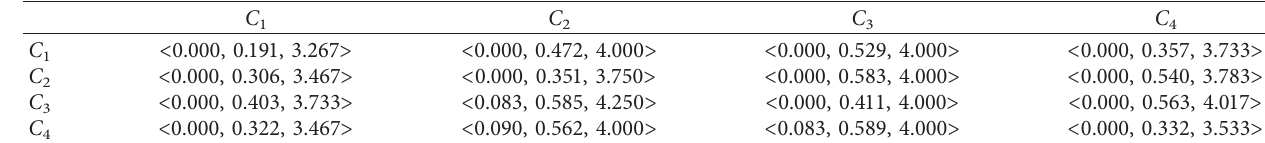
Table 3: Total influencing matrix T .